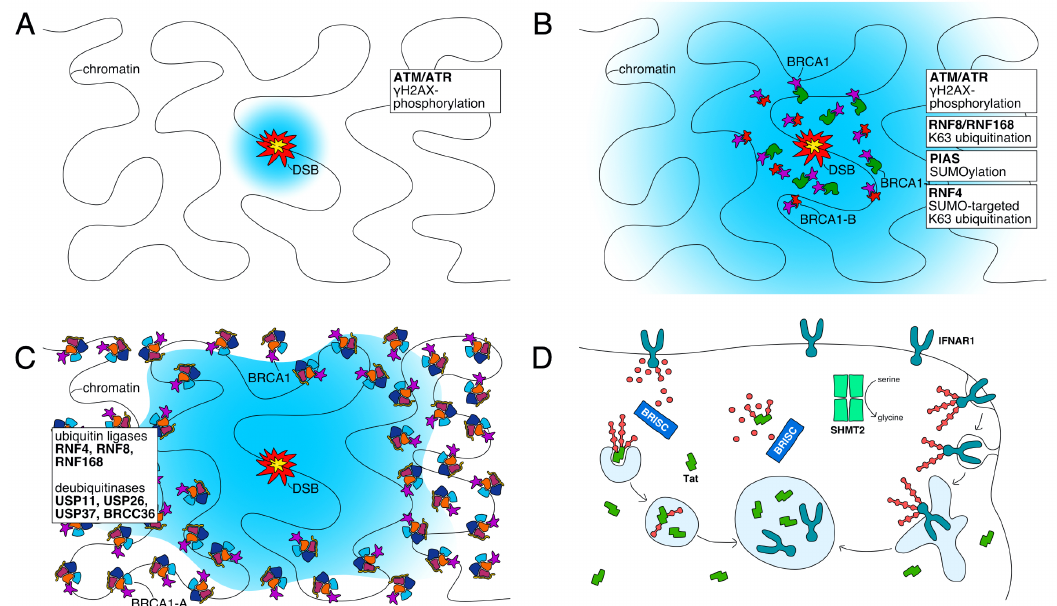
Figure 3. Schematic representation of DNA double-strand break repair associated signaling events ( A – C ) and interferon and Tat degradation control by BRISC ( D ). ( A ) A DNA double-strand break (red, center) has been detected, ARM/ATR marks chromatin surrounding the site of damage (blue). ( B ) Signaling by ubiquitin ligases, sumo ligases, and SUMO-targeted ubiquitin ligases marks chromatin surrounding the site of damage (blue) while BRCA1 is recruited to the site of damage where it engages in resection-promoting complexes. ( C ) DUBs including BRCC36 edit the chromatin marks (blue) and limit their spread. BRCA1 is sequestered to the periphery of the DNA repair focus and withdrawn from the site of damage. ( D ) BRISC degrades K63-linked chains that serve as lysosomal degradation signals from membrane receptor IFNAR1 and soluble viral protein Tat, increasing their stability and